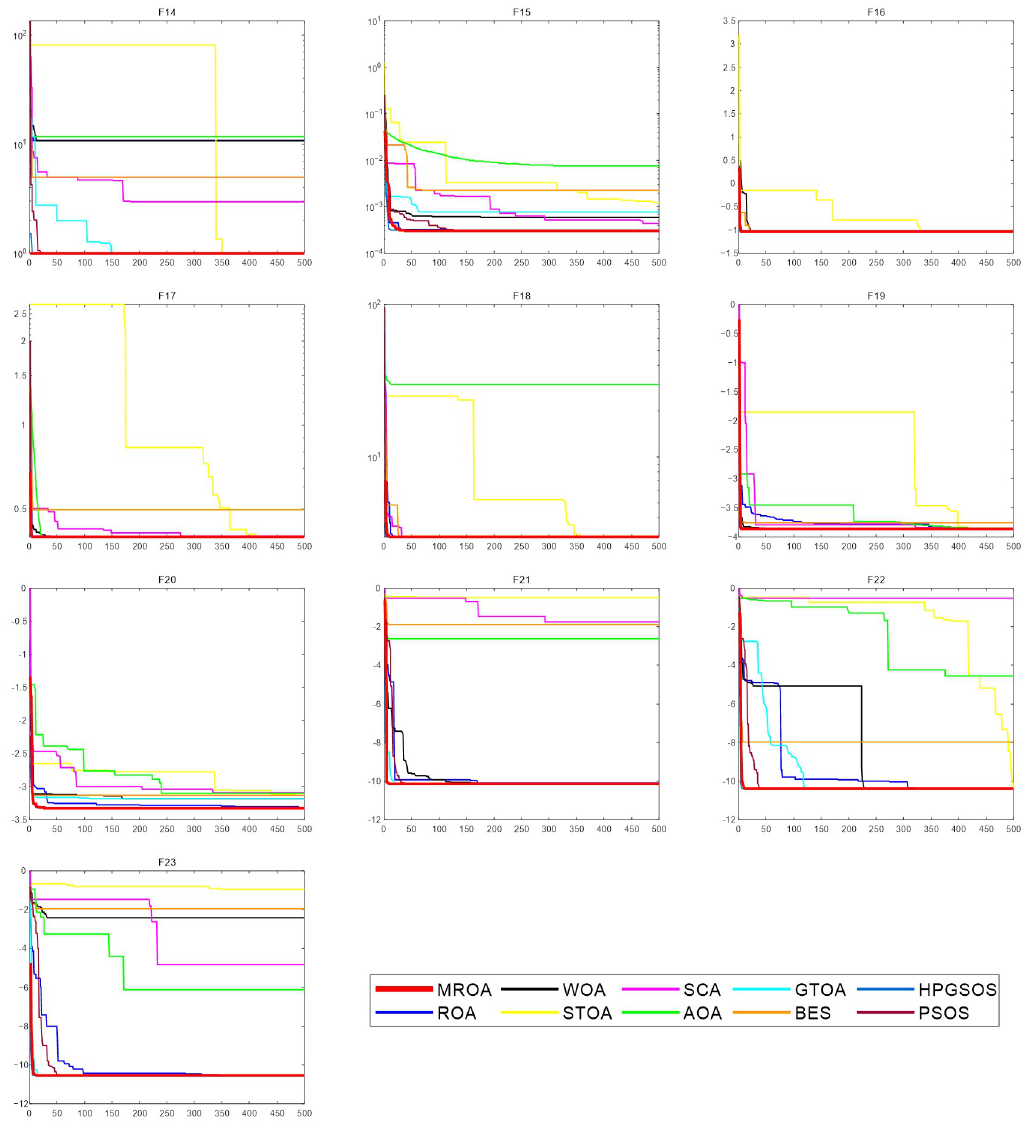
Figure 9. The convergence curves for the optimization algorithms on test functions (F14–F23).